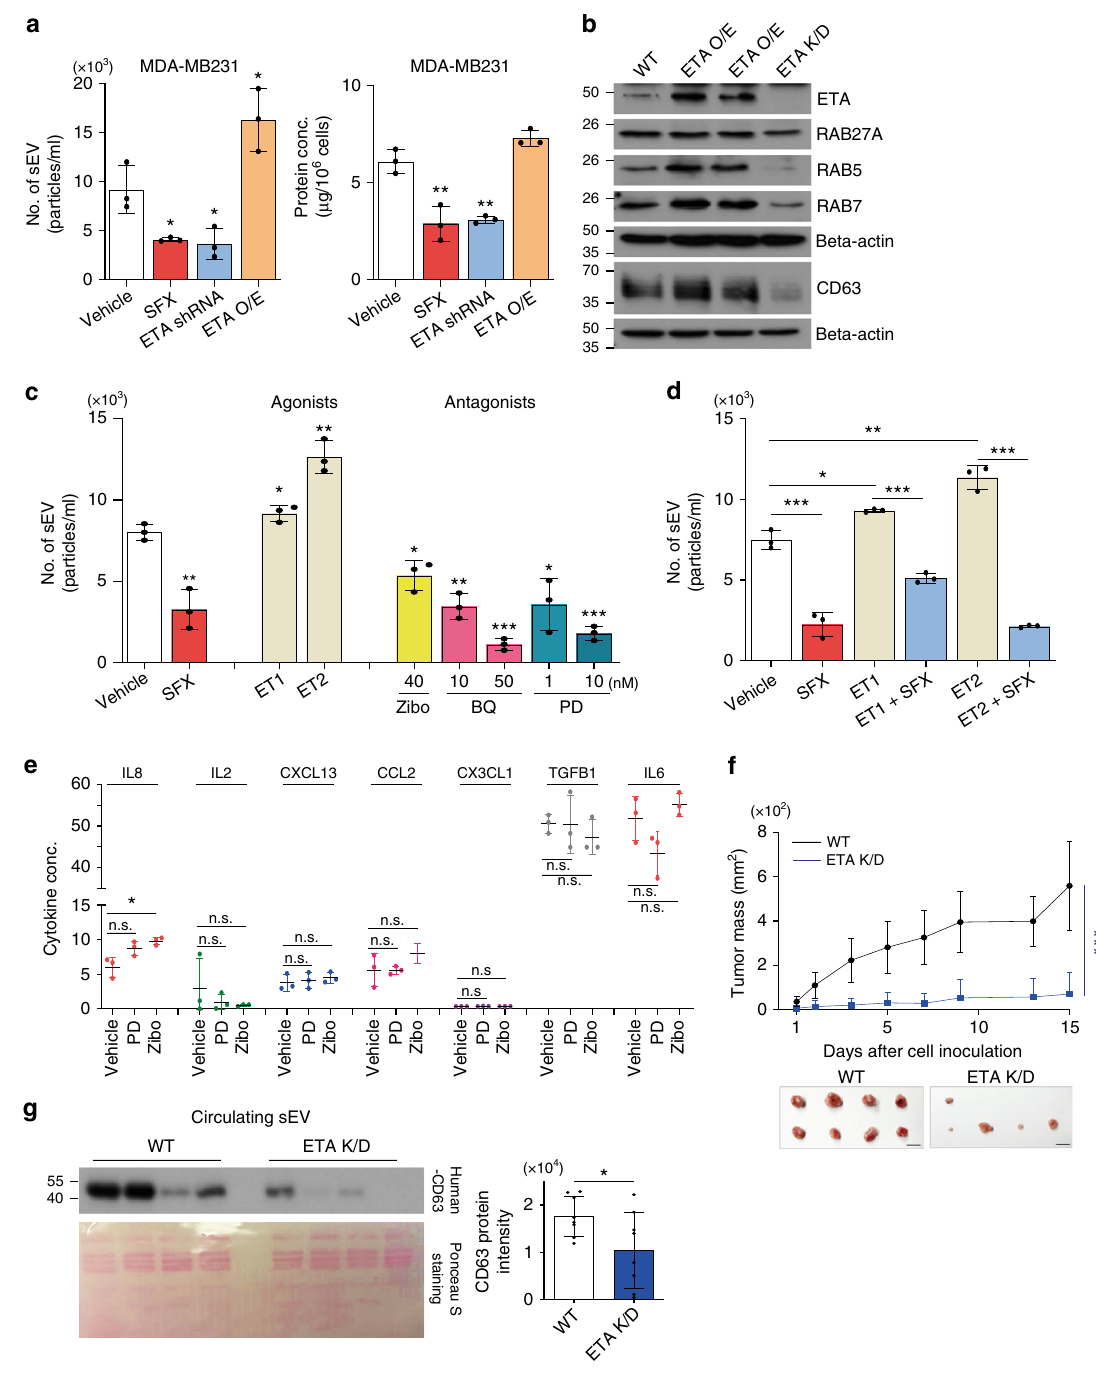
Fig. 5 Identi fi cation of ETA as the novel regulator of sEV biogenesis. a Measurements of the number of sEV secreted (left) and the amounts of sEV proteins (right) from WT, ETA-overexpressed (ETA-OE), and ETA knockdown (K/D) MDA-MB231 cells. n = 3. b Immunoblot of various proteins in ETA-OE and ETA-K/D MDA-MB231 cells. n = 3. c Measurement of the number of sEV secreted and the amount of sEV proteins from ETA agonist- or antagonist- treated MDA-MB231 cells. n = 3. d Measurement of the number of sEV and the amounts of sEV proteins from MDA-MB231 cells treated with 10 nM ET1 or 10 nM ET2 in the presence of 100 μ M SFX. n = 3. e Measurement of soluble proteins secreted from MDA-MB231 cells in the presence of PD156707 or zibotentan for 24 h. The unit of IL8, IL2, CXCL13, CCL2, TGFB1, and IL6 is pg ml − 1 . The unit of CX3CL1 is ng ml − 1 . n = 3. f Tumor mass volume of in BALB/c nude female mice inoculated with MDA-MB231 or MDA-MB231 ETA K/D. Bar, 1 cm. n = 8 per group. g Left top, immunoblot of human CD63 in circulating cancer-cell-derived sEV from MDA-MB231 or MDA-MB231 ETA K/D-bearing mice ( n = 8 per group) where similar amounts of protein/lane were veri fi ed by Ponceau S staining (Bottom). Right, densitometric analysis of the relative protein intensity of CD63. Experiments were performed with 95% con fl uent cells. Signi fi cance was determined using an unpaired two-tailed Student ’ s t -test. *** p < 0.001, ** p < 0.005 and * p < 0.05. Error bar, SD. Source data ( a , c – g ) are provided as a Source Data fi